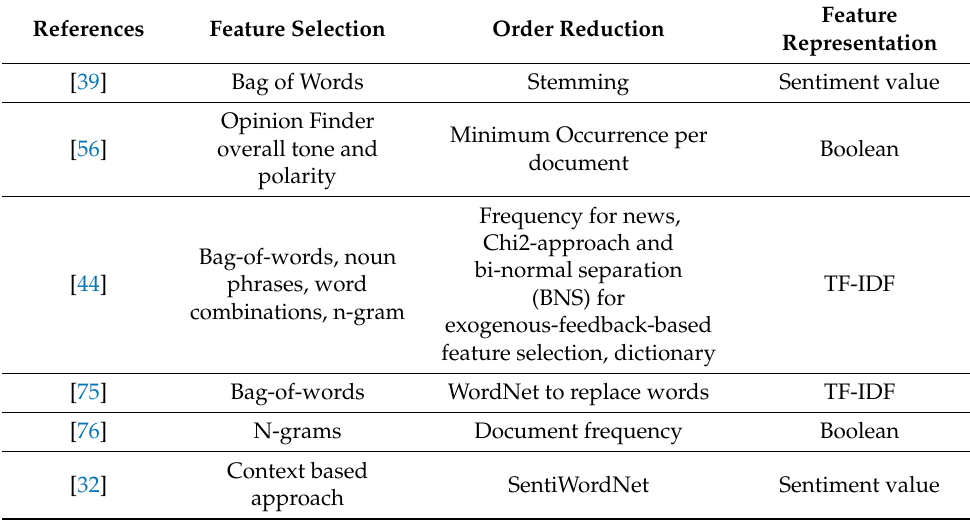
Table 2. Comparison of various pre-processing